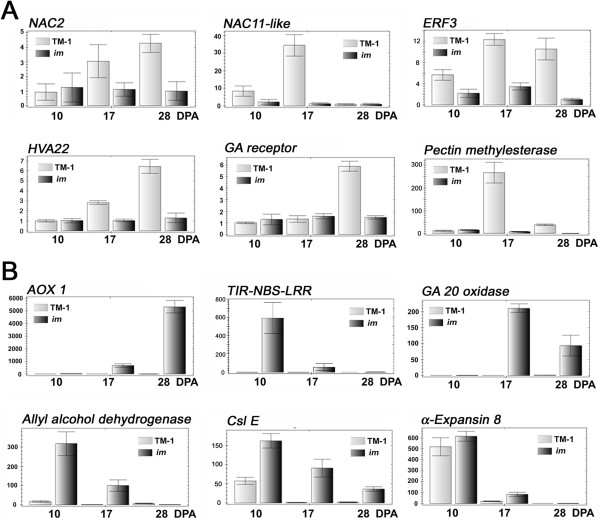
Validation of array data by RT-qPCR analysis. A. Down-regulated genes in the im mutant. NAC2 transcription factor (Ghi.3264.2.A1_s_at), NAC 11-like transcription factor (Ghi.6896.1.A1_s_at), ethylene responsive element binding factor 3 (ERF3) transcription factor (Ghi.10747.1.S1_at), HVA22 protein (GhiAffx.8267.1.A1_s_at), GA receptor (Gra.1544.1.A1_s_at) and pectin methylesterase (Ghi.5186.1.A1_at). B. Up-regulated genes in the im mutant. alternative oxidase 1 (AOX 1, Ghi.3408.1.A1_at), TIR-NBS-LRR resistance protein (GhiAffx.41878.1.S1_at), GA 20 oxidase (Ghi.6164.1.A1_at), allyl alcohol dehydrogenase (Ghi.8523.1.A1_at), cellulose synthase-like protein (CslE, Ghi.3562.1.A1_at), and α-expansin 8 (Ghi.2039.1.S1_x_at). All RT-qPCR analyses were performed with three biological replications at each time point with five technical replications. The error bars represent SD.